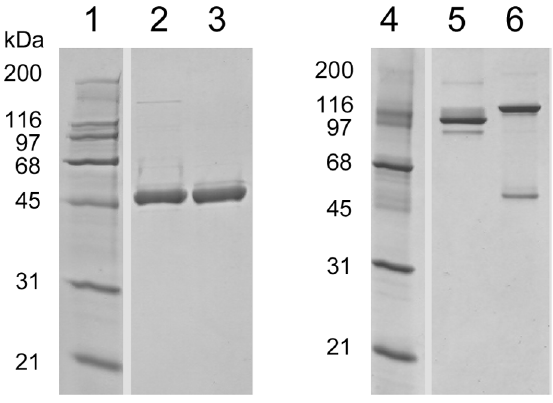
Figure 2. SDS-PAGE analysis of purified G-CSF/IgG-Fc direct fusion proteins . Lanes 1-3 are reducing SDS-PAGE and lanes 4-6 are non-reducing SDS-PAGE. Lanes 1 and 4 are molecular weight markers; lanes 2 and 5 are G-CSF/IgG1-FcD; and lanes 3 and 6 are G-CSF/IgG4- FcD.